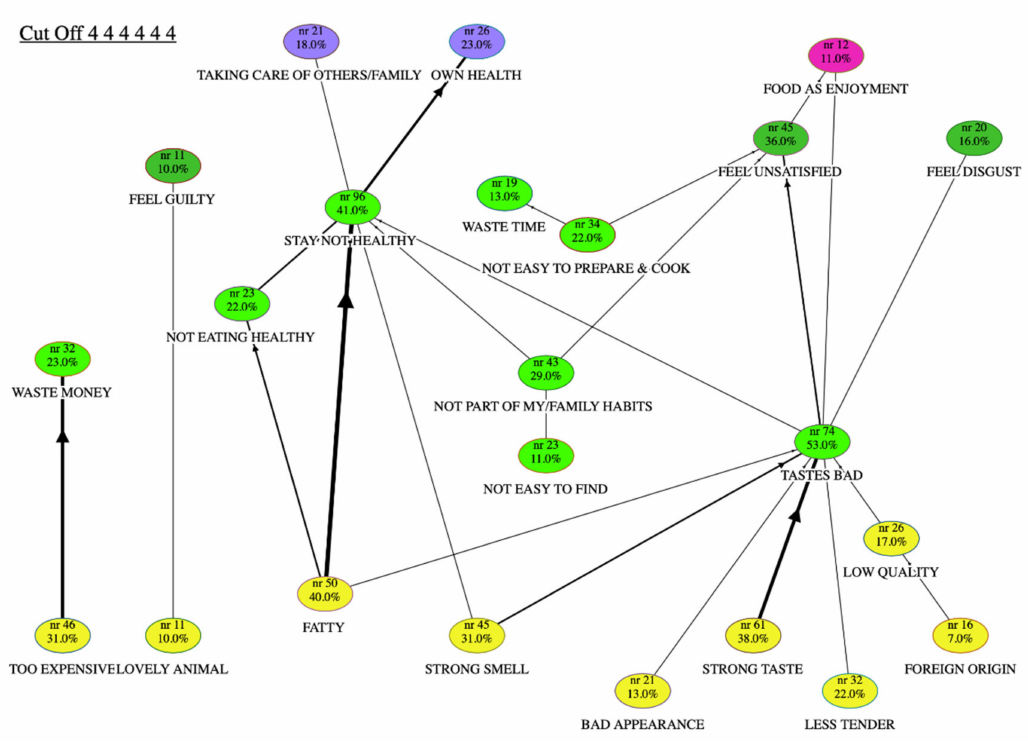
Figure 2. Hierarchical value map of non-consumers of sheep and goat meat. Table 2. Description of the hierarchical value map